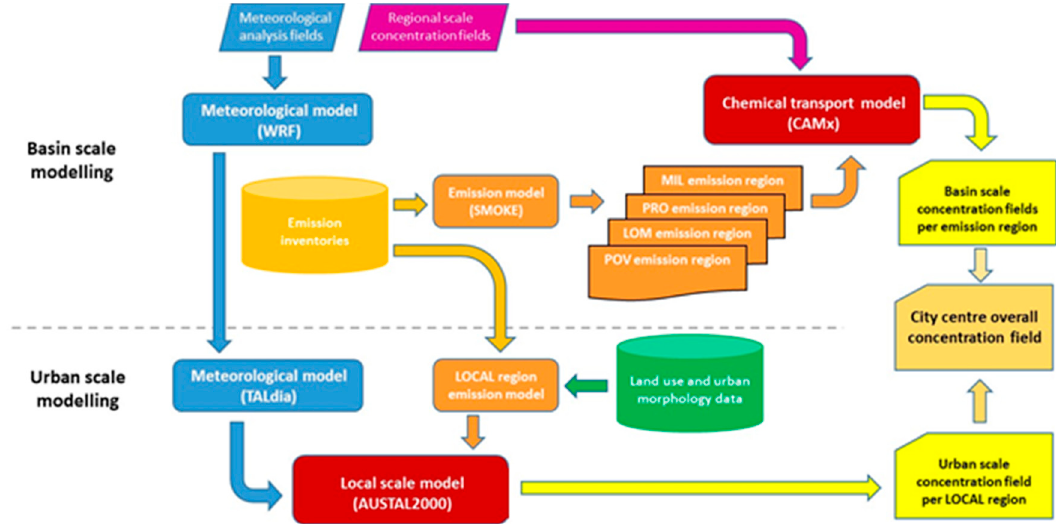
Figure 1. Hybrid modeling system setup.